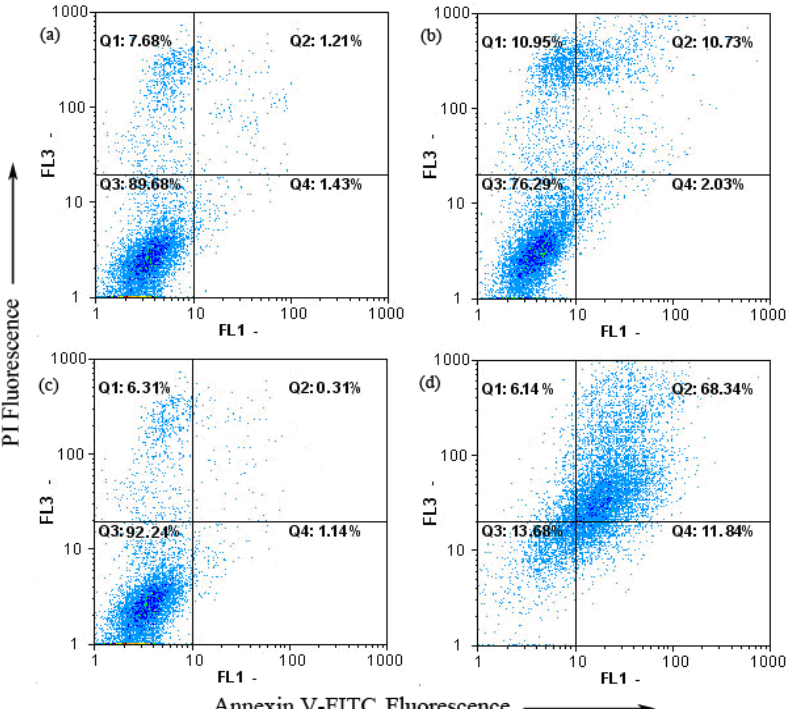
Figure 5. Tamoxifen-induced apoptosis in pCMV6-CDK10-keloid fibroblast